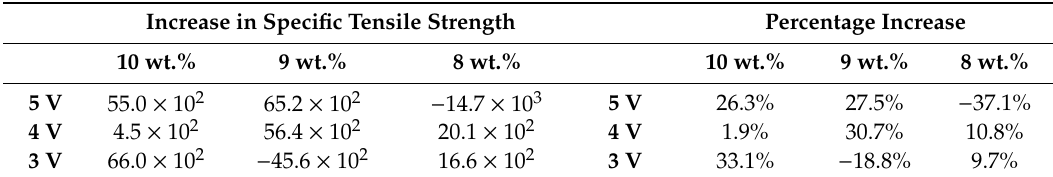
Table 3. Improvement in specific tensile strength in improved system.